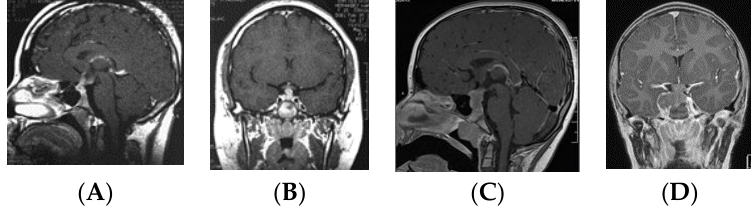
Figure 4. Type III. Post-contrast MR, sagittal ( A ) and coronal ( B ) views of a patient with S-GCT. Note the tumor from the floor of the third ventricle to the sella turcica. Post-contrast MR, sagittal ( C ) and coronal ( D ) views of a patient with S-GCT. Note the tumor from the floor of the third ventricle to sella turcica with further extension into the cavernous sinus.